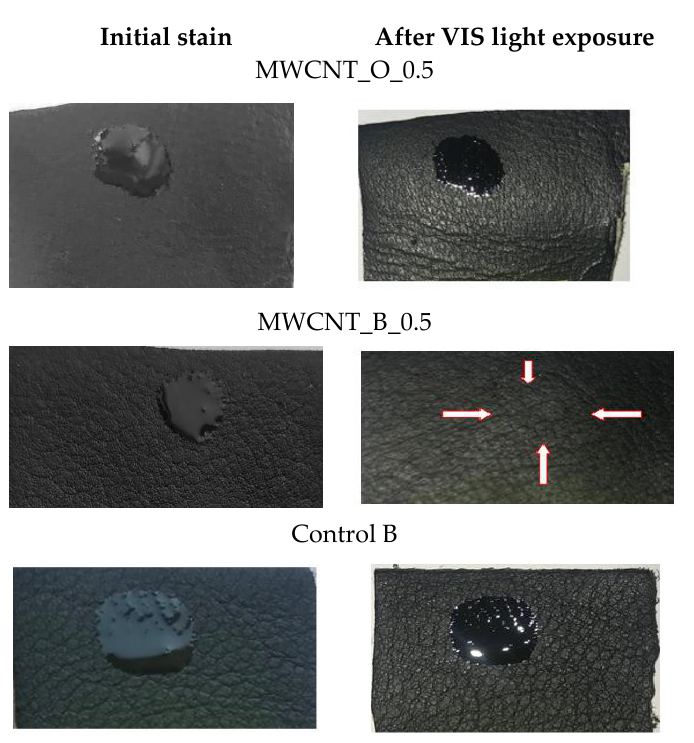
Figure 4. Photocatalytic decomposition of the olive oil stain on the bovine leather surface treated with 0.5% MWCNTs after 6 h of visible light exposure compared to the bovine control sample and MWCNT_O_0.5 sample, digital photos.